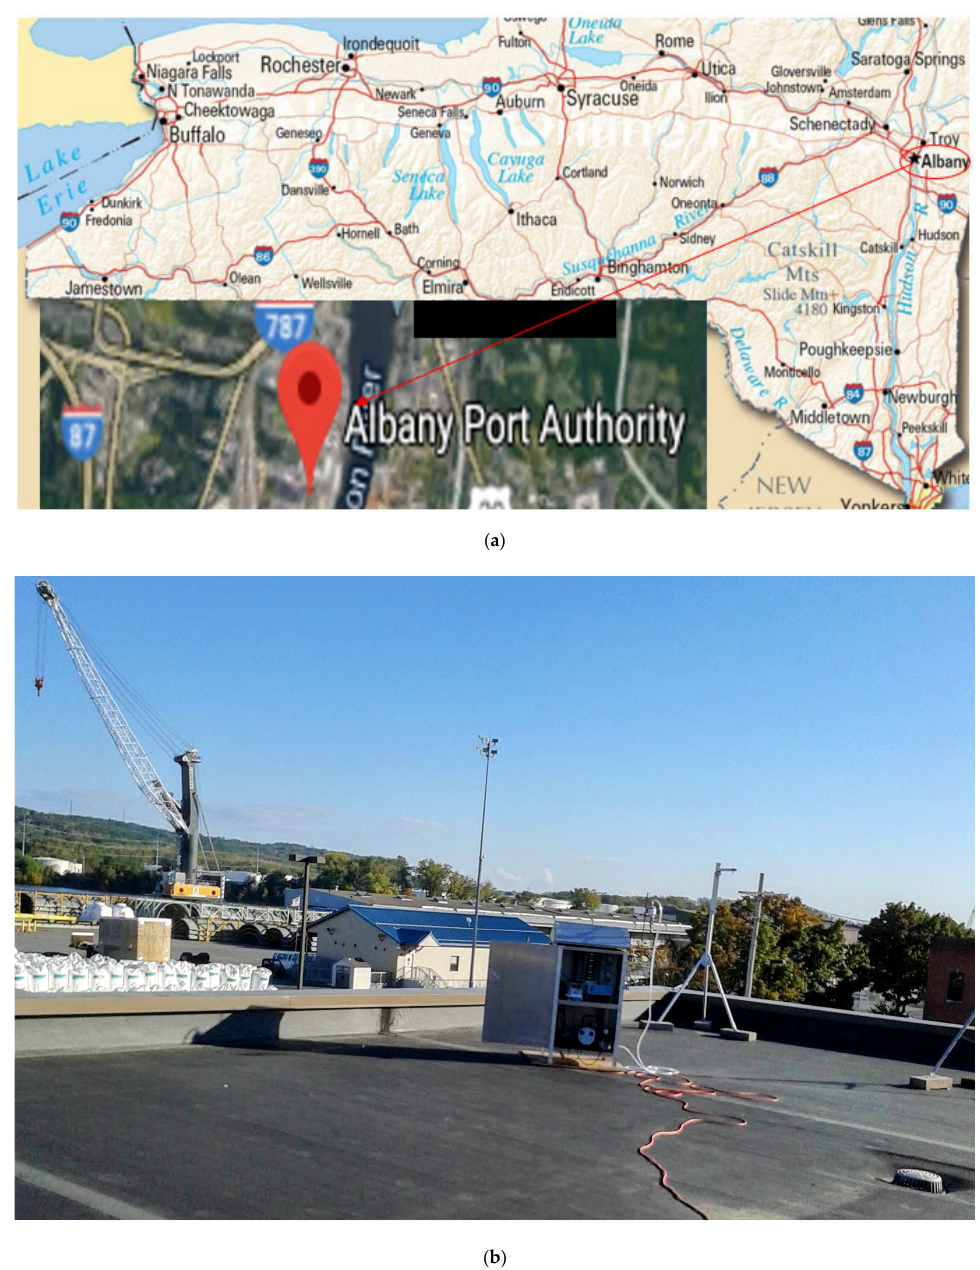
Figure 1. ( a ) Map of New York State showing the sampling site at the Port of Albany. ( b ). Rooftop monitoring location adjacent to the Port of Albany.